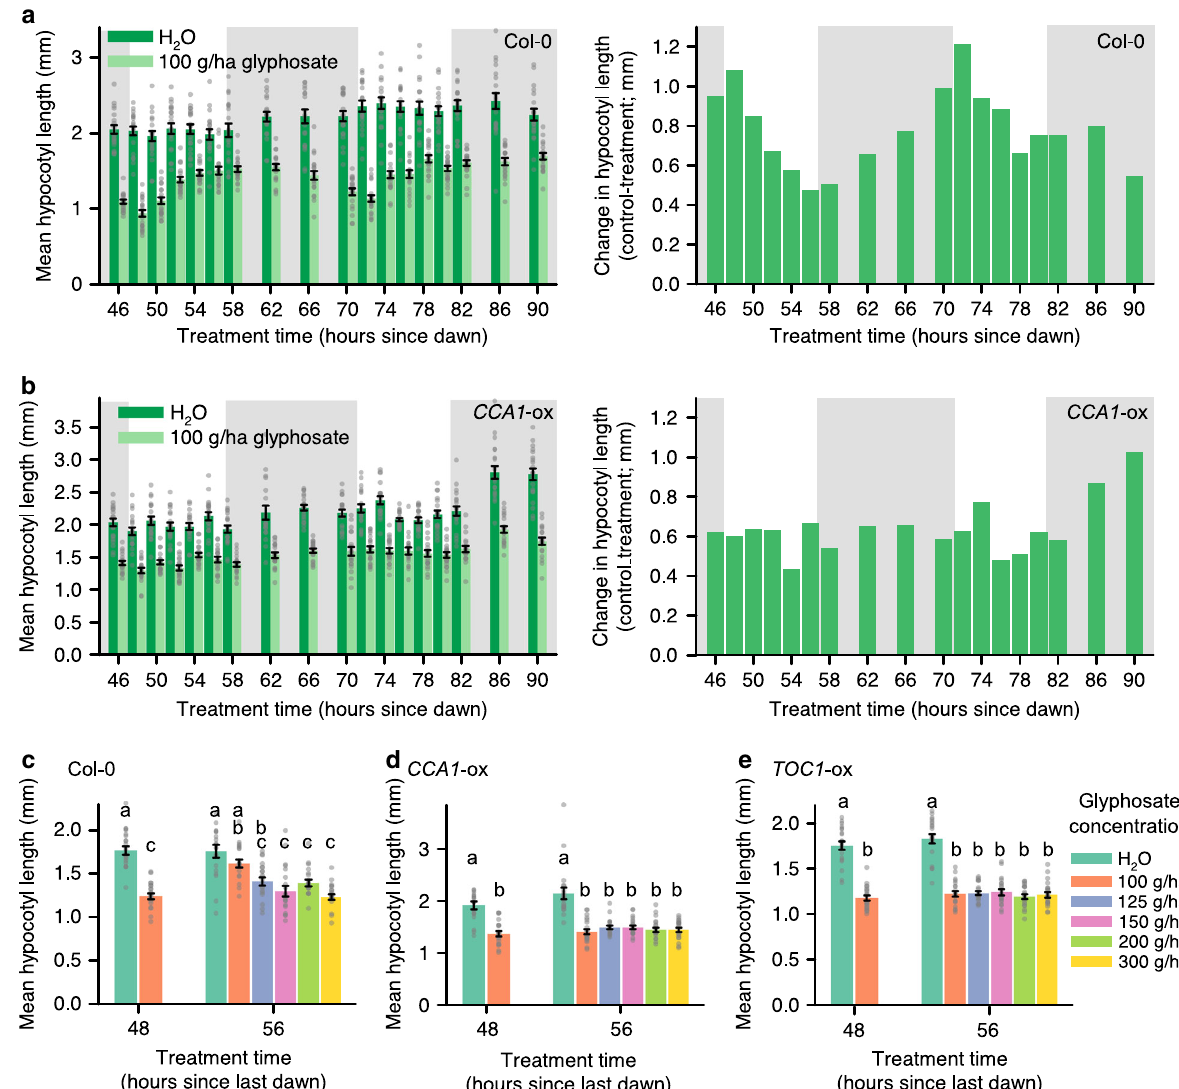
Fig. 2 Circadian regulation of the sensitivity of plants to glyphosate. a, b Under constant light conditions, hypocotyl length of seedlings treated with 100 g/ ha glyphosate at times speci fi ed, in a Col-0 and b CCA1 -ox seedlings. Graphs show (left) hypocotyl length and (right) change in hypocotyl length caused by glyphosate. Grey shading indicates subjective night. c – e Glyphosate concentration required to produce equivalent attenuation of hypocotyl length at subjective dawn (48 h) and subjective dusk (56 h) in c Col-0, d CCA1- ox and e TOC1- ox. Signi fi cance determined by a, b two-way ANOVA c – e one-way ANOVA and post-hoc Tukey analysis. Different letters indicate signi fi cant differences between means. Data are mean ± s.e.m; n = 18 – 20. Source data are provided in the Source Data fi